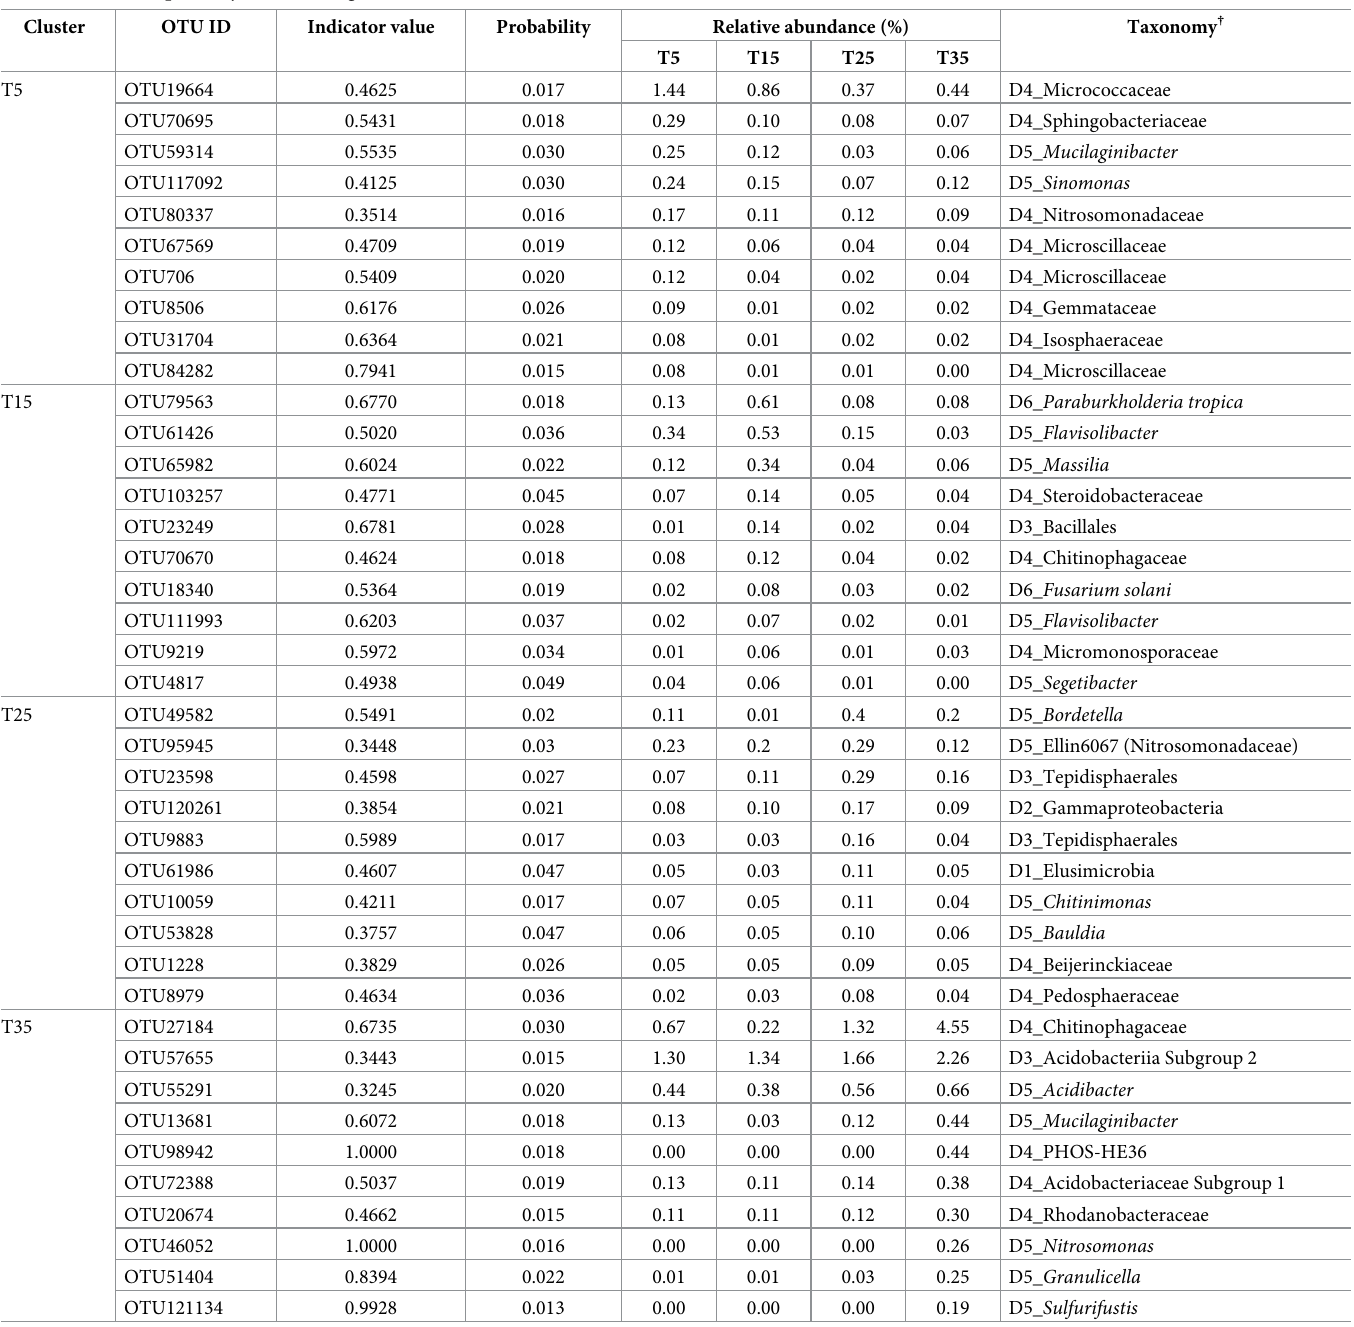
Table 1. Indicator species by treatment